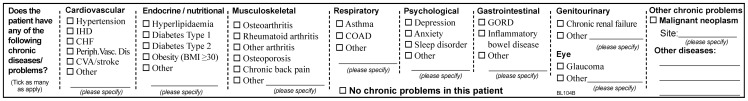
BEACH sub-study questionnaire on prevalence of chronic conditions.